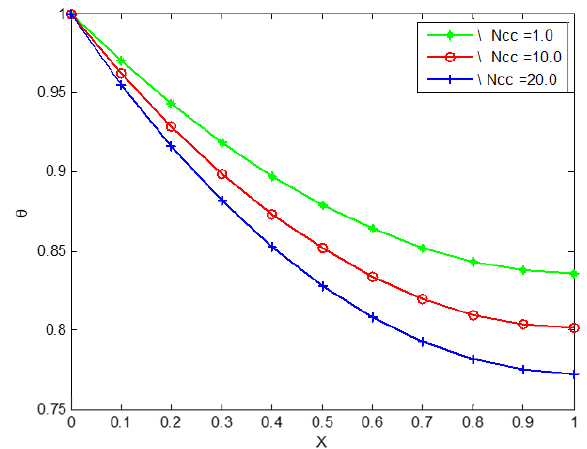
Figure 14. The effect of convective conductive parameter (Ncc) on the temperature distribution of a silicon nitride porous fin